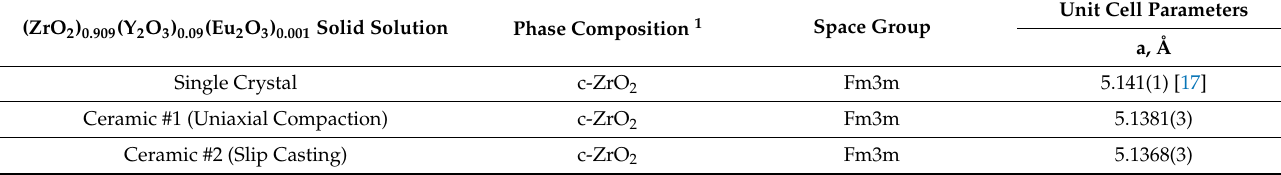
Figure 2. Fragments of the X-ray diffraction patterns of (ZrO 2 ) 0.909 (Y 2 O 3 ) 0.09 (Eu 2 O 3 ) 0.001 ceramic solid solutions synthesized using different methods from crushed single crystals: (1) uniaxial compaction; (2) slip casting. Table 1. Phase composition and lattice parameters of (ZrO 2 ) 0.909 (Y 2 O 3 ) 0.09 (Eu 2 O 3 ) 0.001 single crystals and ceramics synthesized using different methods from crushed single crystals.